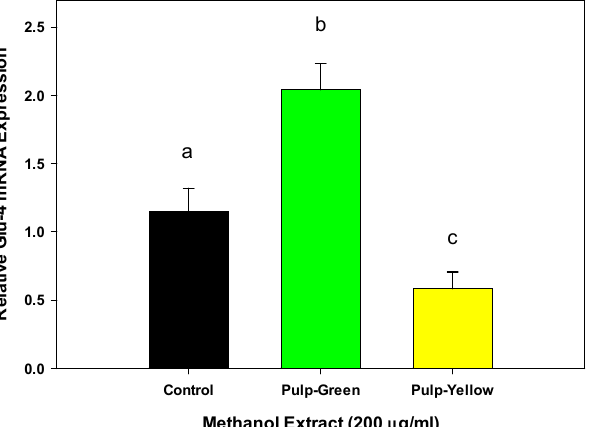
Figure 8. Effect of papaya pulp on Glut-4 expression. Expression of Glut-4 was determined using RT-PCR following steps as described in the text. The data were expressed as relative glut-4 mRNA expression from vehicle-treated control cells. The statistical analysis was performed using one-way ANOVA with Tukey’s HSD post hoc test ( n = 4). The statistically significant difference at p < 0.05 between groups was represented by different letters.